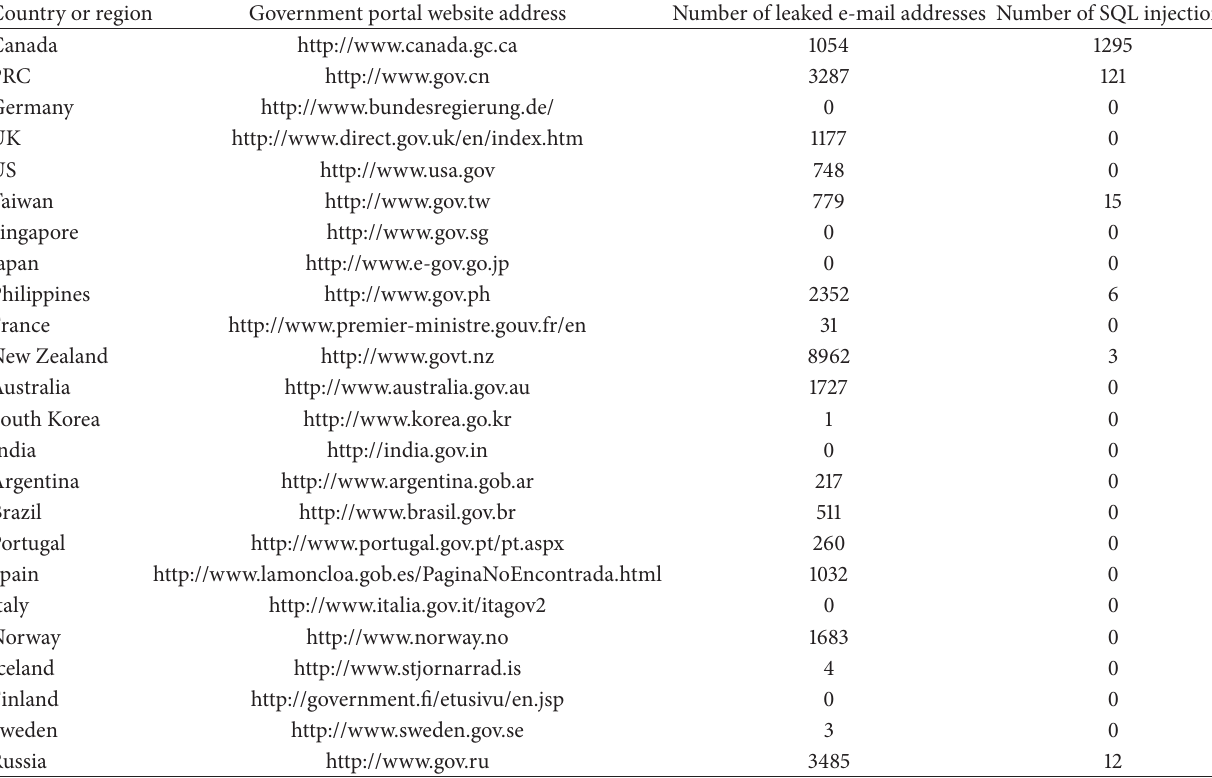
Table 1: Testing results of 24 countries or regions.